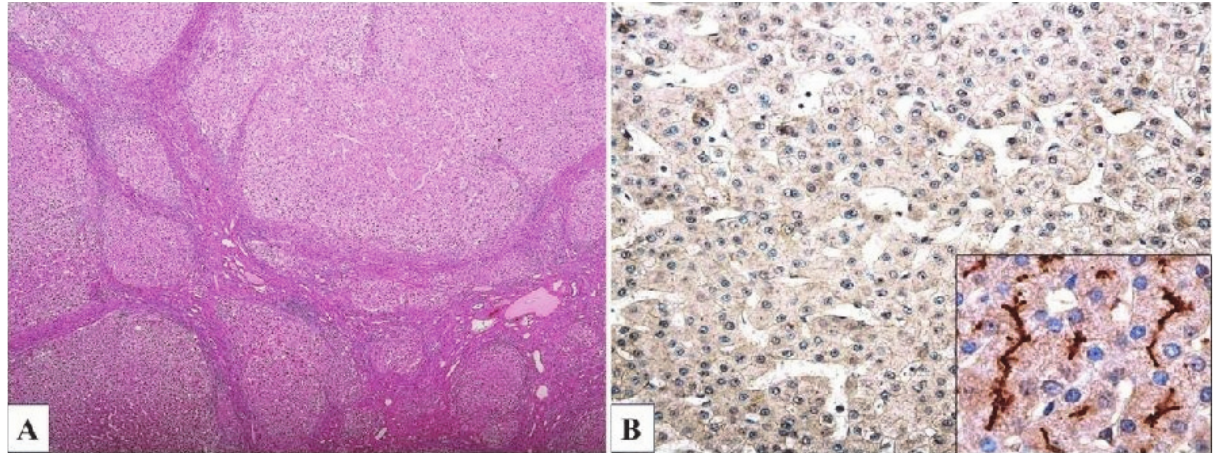
Fig. 1. Histopathology findings in the explanted liver. (A) Haematoxylin and eosin, original magnification x40, (B) MDR3 immunohistochemistry, original magnification x200 (inset,